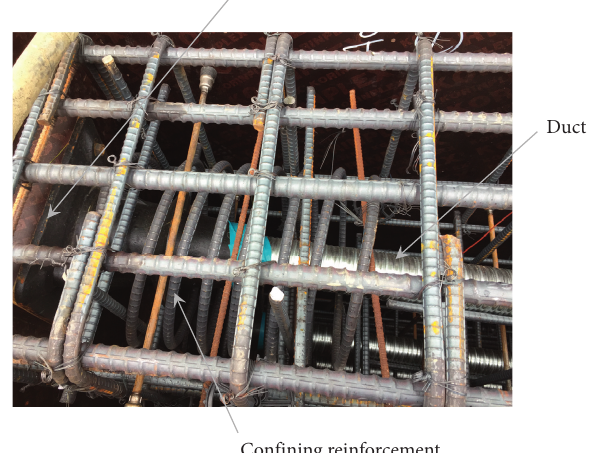
Figure 3: Anchorage device, duct, and confining reinforcement.